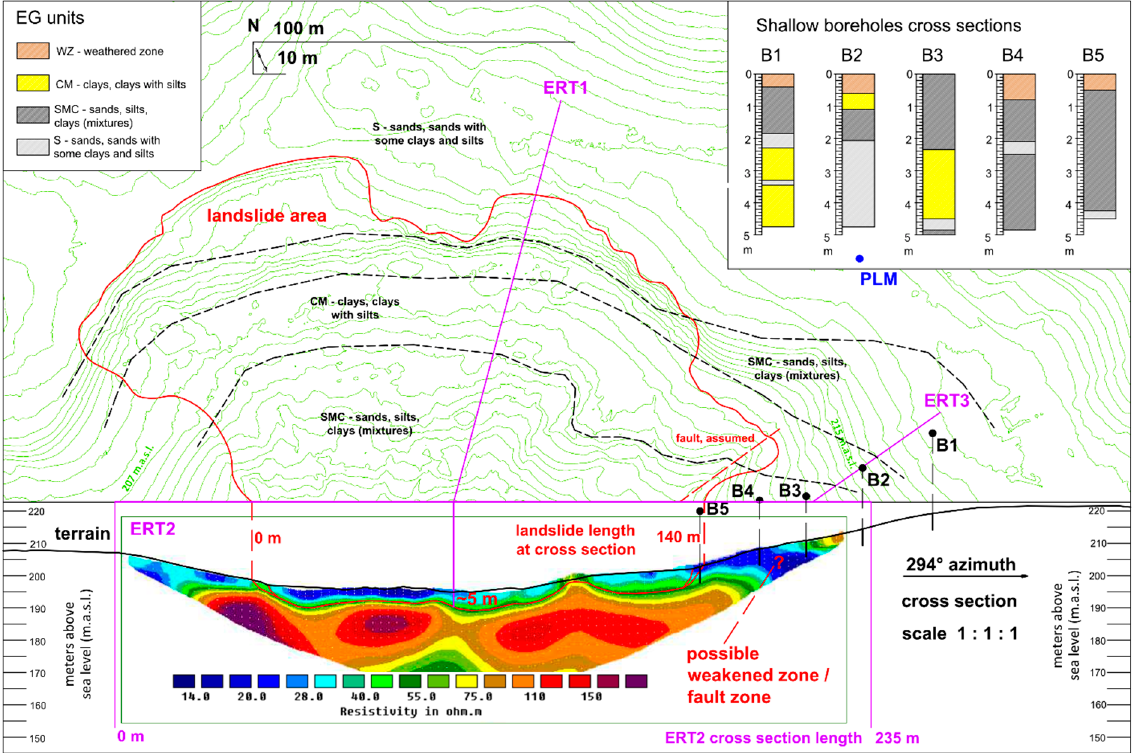
Figure 6. Sliding surfaces depth interpretation at ERT2 with a possible weakened zone in the vicinity of B4 and B5.